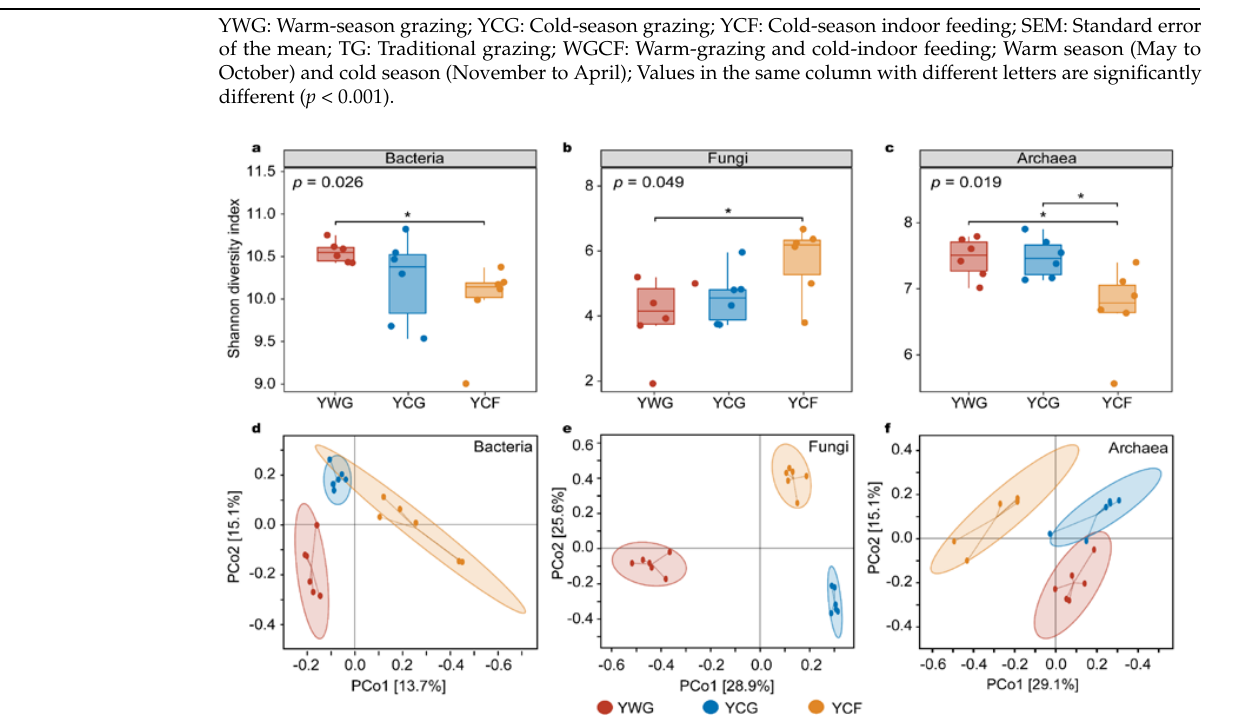
Figure 2. Diversity analysis of rumen microbiota between different experimental groups of yaks.